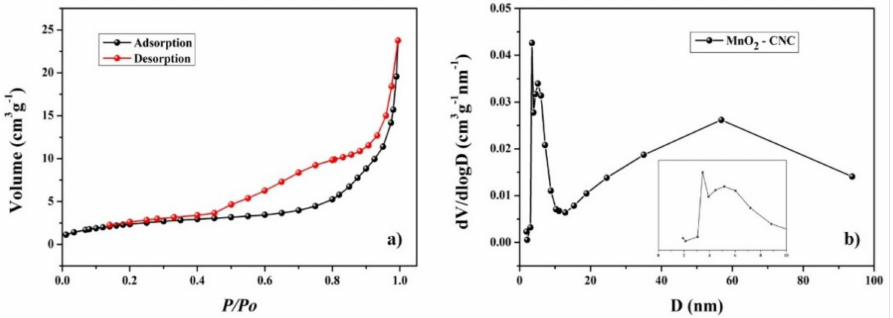
Figure 4. ( a ) Nitrogen adsorption-desorption isotherm and ( b ) BJH pore size distribution of the composite.